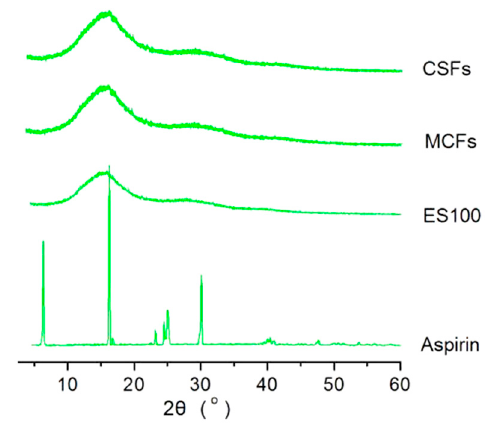
Figure 6. The XRD patterns of the raw materials (aspirin and Eudragit S100 (ES100)) and also their nanofibers MCFs and CSFs from different electrospinning processes.